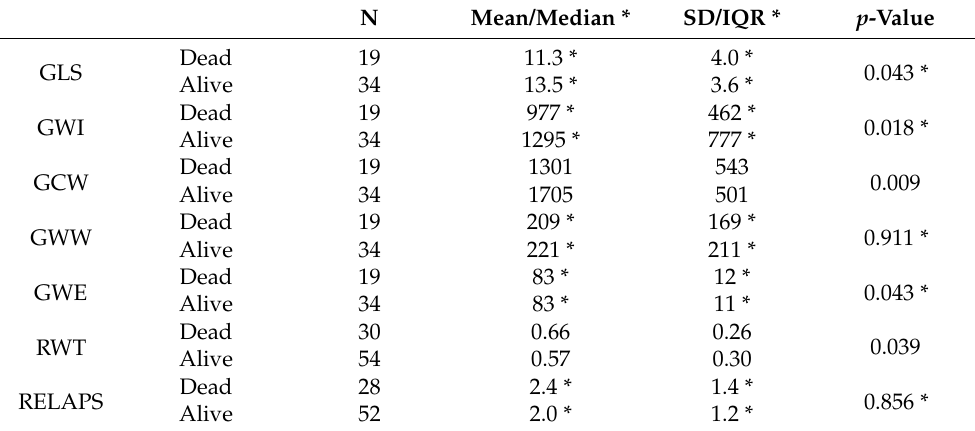
Table 5. Myocardial work and death in